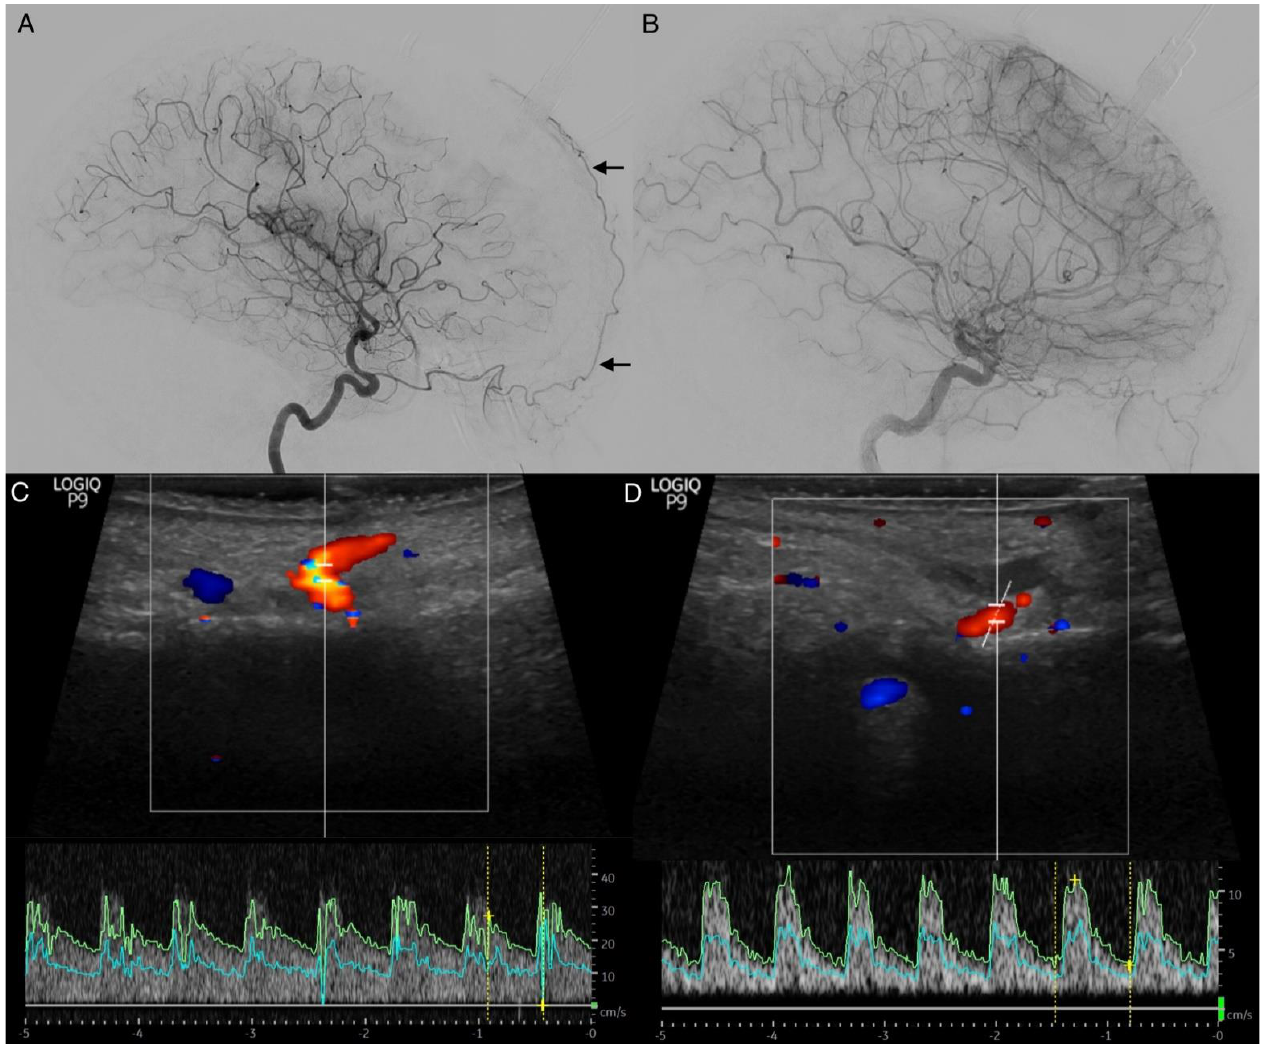
Figure 7. Doppler sonography of the supratrochlear artery in carotid artery vasospasm. ( A , B ): Lateral projections of the right ( A ) and left ( B ) anterior circulation in digital subtraction angiography. The right-sided angiogram shows the intradural internal carotid artery (ICA) vasospasm and an enlarged supratrochlear artery (STA, arrows). The right-sided angiogram shows the physiological appearance of the STA without intradural ICA vasospasm. ( C , D ): Transcutaneous ultrasound measurements of the right ( C ) and left ( D ) supratrochlear artery at the superior margin of the orbit. The flow velocity of the right supratrochlear artery in high-grade cerebral vasospasm was tripled compared to the counterside (mean flow velocity: right 12.3 cm/s, left 4.3 cm/s, systolic velocity: right 27.4 cm/s, left 11 cm/s; diastolic velocity: right 0 cm/s, left 3.7 cm/s; resistant index: right 1.00, left 0.66; pulsatility index: right 1.36; left 1.07).